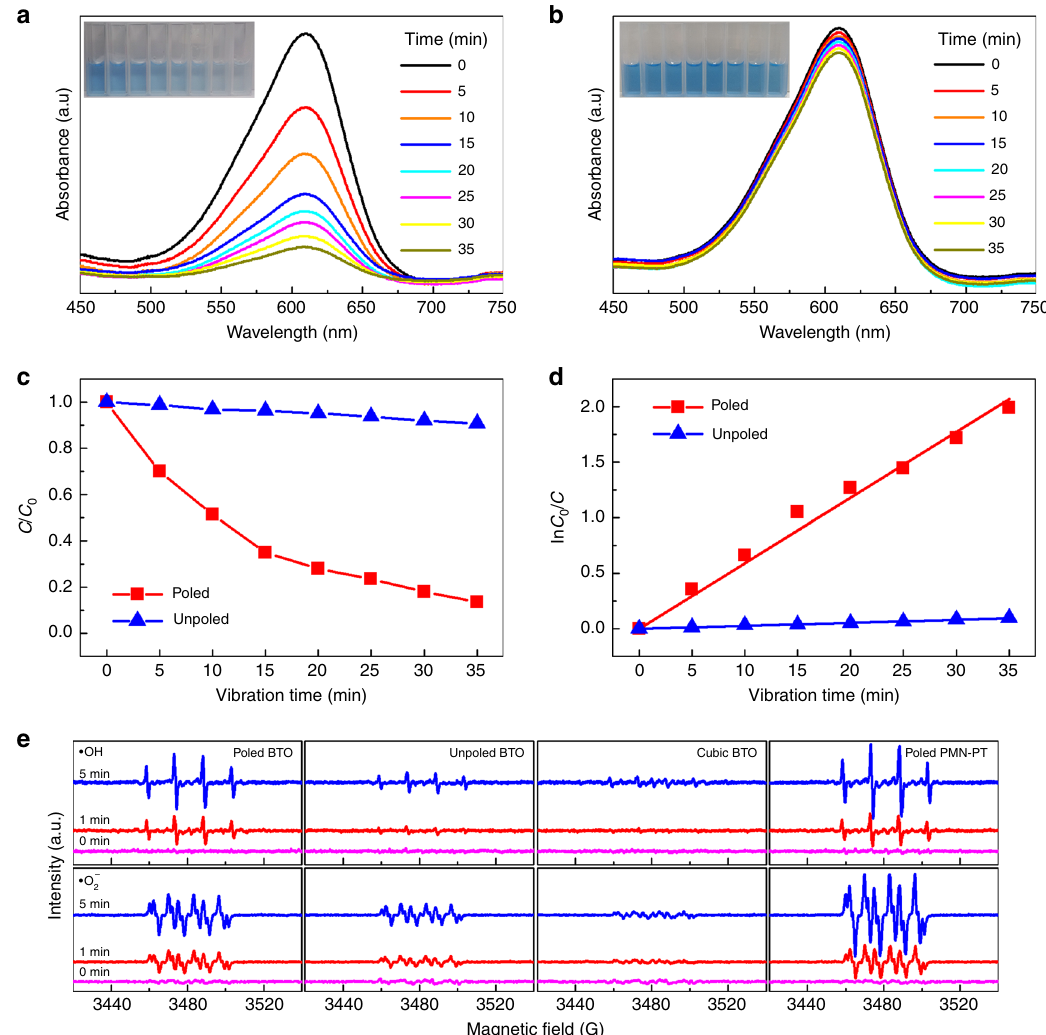
Fig. 3 Degradation properties of piezo-catalysis. UV-Vis absorption spectra of Indigo Carmine solutions at various vibration time for the a poled and b unpoled BTO nanoparticles. The inset in each Figure is a series of photographs of a piezo-catalyzed Indigo Carmine dye solution time progression from left to right. Piezo-catalytic degradation ef fi ciency performance of the poled and unpoled BTO nanoparticles in c direct concentration ratio C / C 0 and d logarithmic relationship of ln( C 0 / C ) by fi tting with a linear function. e Electron paramagnetic resonance spectra (EPR) of radical spin-trapped by 5,5- dimethyl-1-pyrroline N-oxide (DMPO) over different piezo-catalysts in aqueous dispersion (top) and dimethyl sulfoxide (DMSO) dispersion